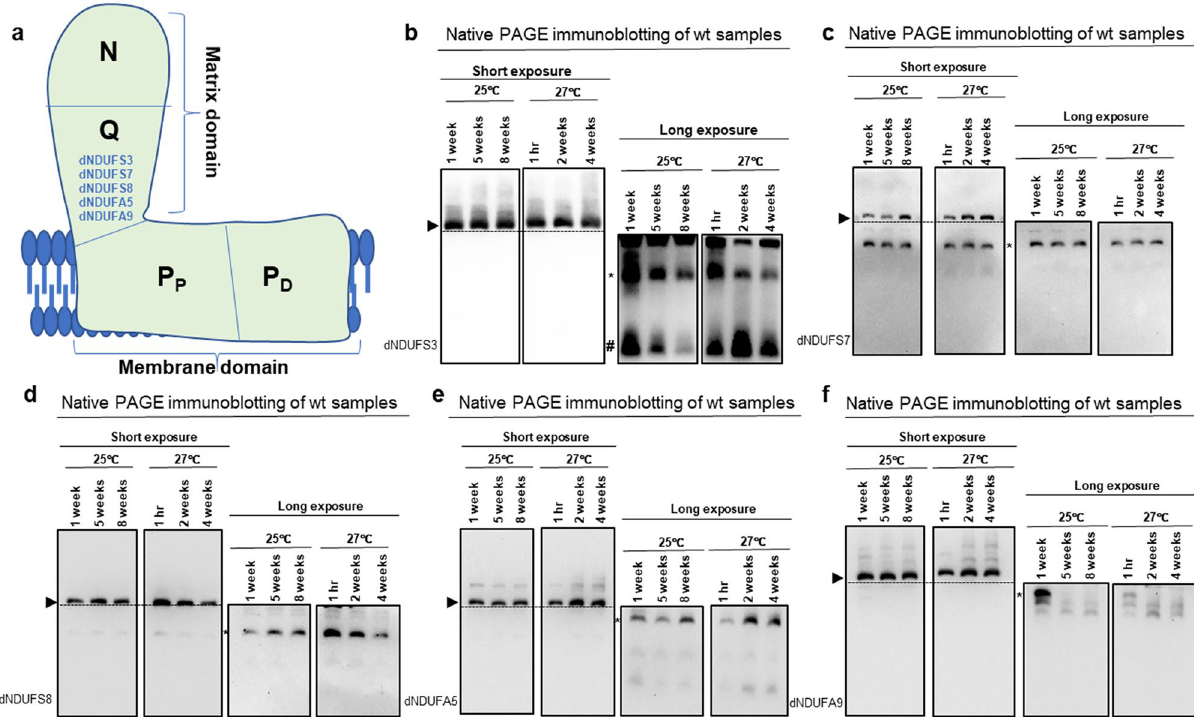
Figure 1. The expression of dNDUFS3 in subcomplexes is down-regulated with age. ( a ) A depiction of mitochondrial CI showing the matrix and membrane domains oriented almost orthogonally to each other, and the relative positions of the N-, Q-, P P - and P D -modules. A commercially available antibody that detects dNDUFS3 and antibodies we generated against dNDUFS7, dNDUFS8, dNDUFA5 and dNDUFA9 were used to examine the biogenesis of the Q-module. ( b – f ) Mitochondrial preparations from thoraces dissected from Dmef2-Gal4/w 1118 (wt) flies raised at 25 °C or 27 °C for up to 8 weeks and 4 weeks, respectively, were analyzed by BN-PAGE, followed by immunoblotting with the antibodies indicated. The blots were imaged following a short exposure to detect the holoenzyme (fully-assembled CI) and supercomplexes, after which the region corresponding to the holoenzyme and supercomplexes was cut off, and the rest of the blot re-imaged after a longer exposure to detect the subcomplexes. The following antibodies were used: anti-NDUFS3 which detects dNDUFS3 ( b ), anti-dNDUFS7 ( c ), anti-dNDUFS8 ( d ), anti-dNDUFA5 ( e ) and anti-dNDUFA9 ( f ). The arrowheads mark the positions of the holoenzyme and the asterisks denote subcomplexes discussed in the text. Initiating and intermediary Q-module subcomplexes in panel ( b ) are denoted by # and *, respectively. We used the amount of holoenzyme detected by each antibody as a loading control for the subcomplexes. See Figures S2 and S3 for replicates and S7 for full-length gels and